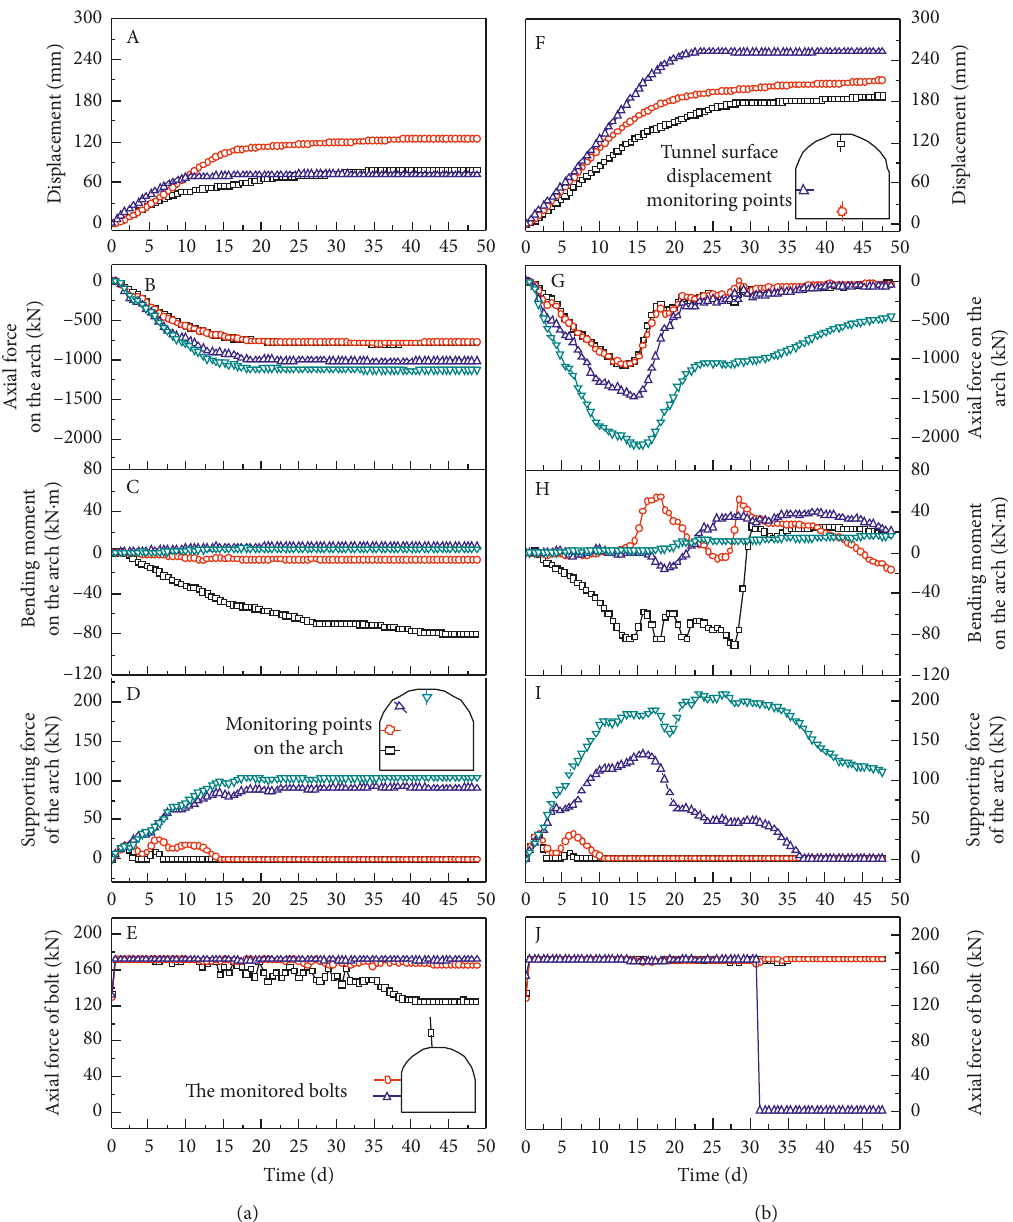
Figure 7: Evolution curves of (a) Scheme 6 ( λ � 0.5) and (b) Scheme 10 ( λ � 0.5). (A) ∼ (E): Evolution curves of roadway displacement, arch axial force, arch bending moment, arch supporting force, and rock bolt axial force of Scheme 6, respectively; (F) ∼ (J): Evolution curves of roadway displacement, arch axial force, arch bending moment, arch supporting force, and rock bolt axial force of Scheme 10, respectively.